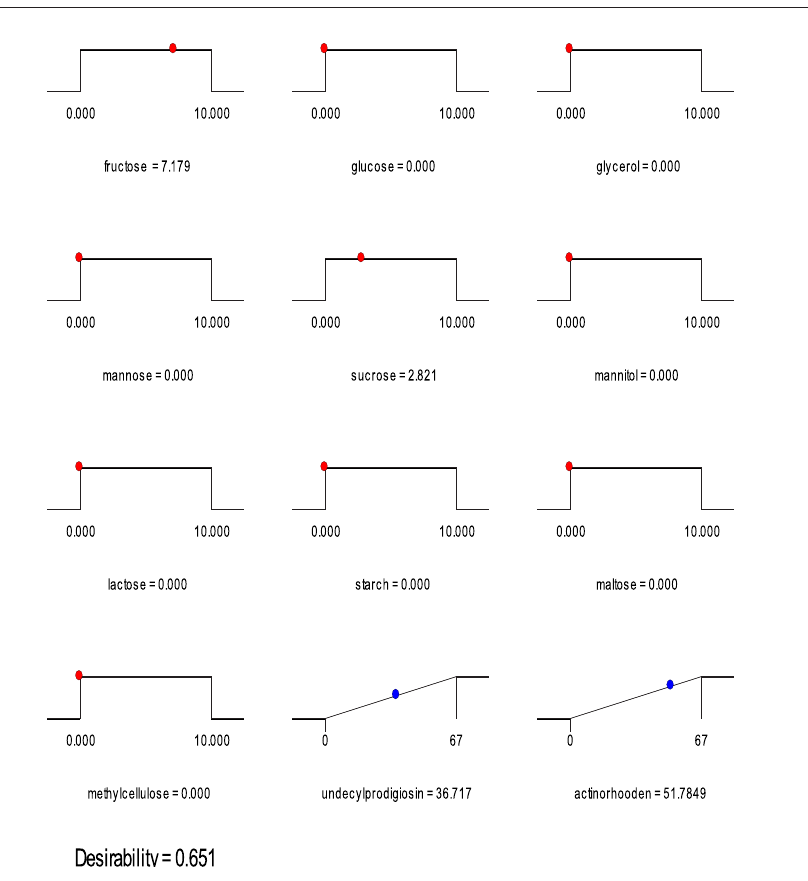
Fig. 5. Ramp chart for statistically optimize carbone source for both undecylprodigiosin and actinorhodin production by Streptomyces coelicolor A(3)2